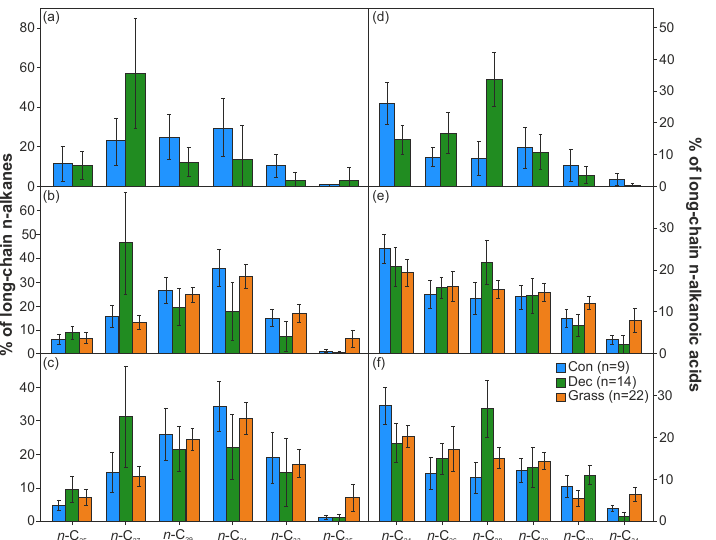
Figure 3. Chain length patterns for odd long-chain n -alkanes in (a) litter, (b) Ah1 and (c) Ah2, as well as long- and even-chain n -alkanoic acids in (d) litter, (e) Ah1 and (f) Ah2.